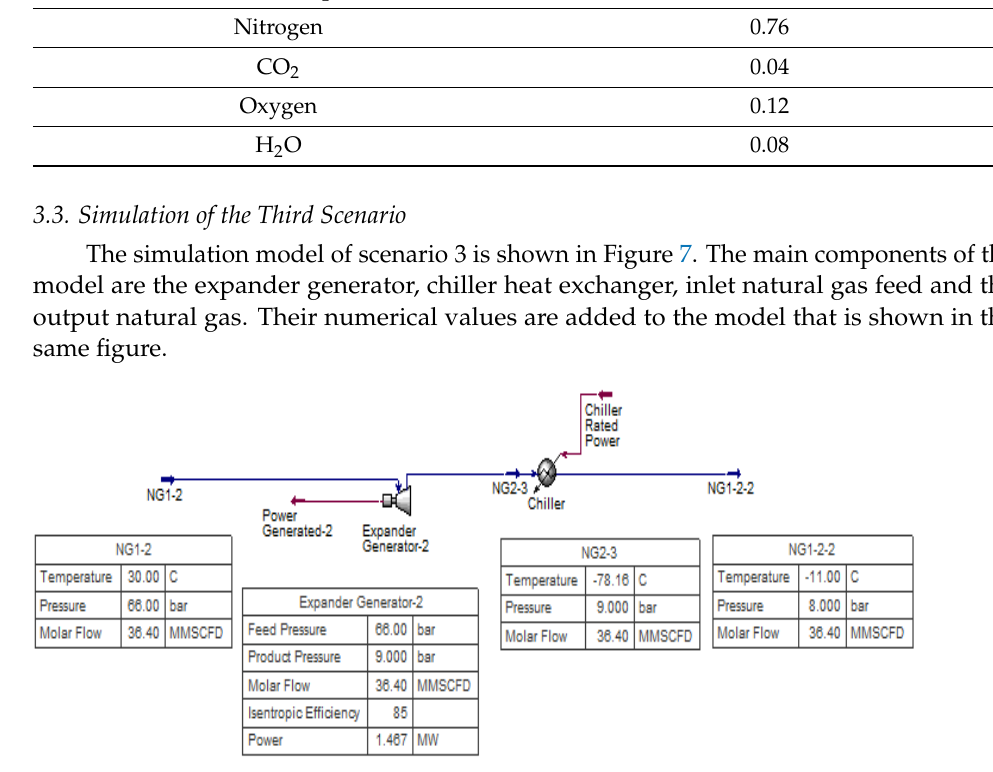
Table 5. Flue gas composition percentages in the simulation model.